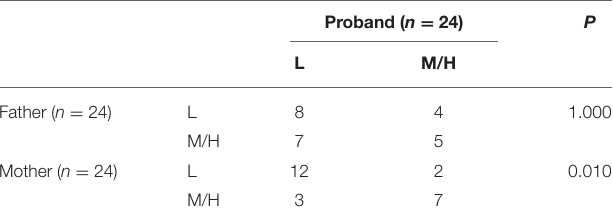
TABLE 6 | The different of physical activity between probands and their parents. Proband ( n =